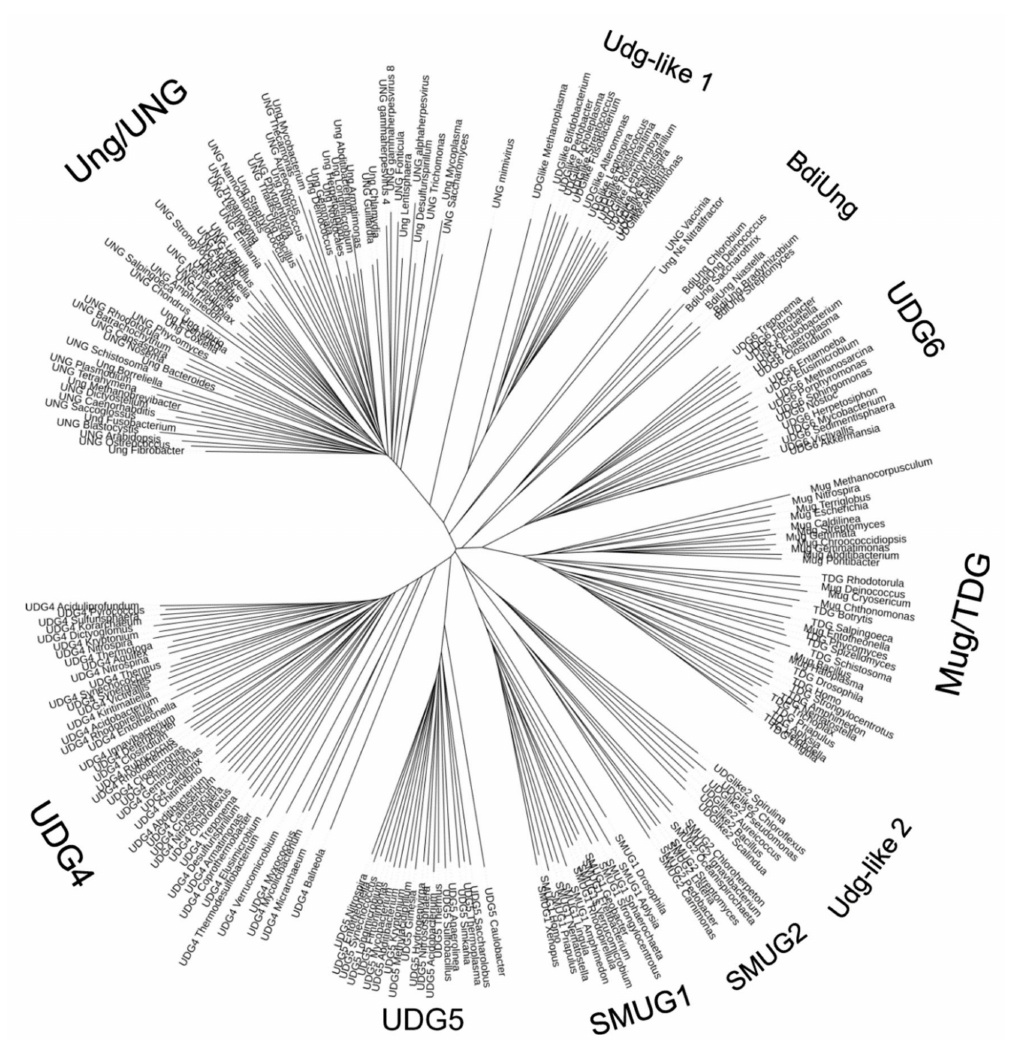
Figure 3. Unrooted tree of uracil–DNA glycosylases, limited to one per taxonomic phylum. The phylogenetic tree was produced by Clustal Omega [124] and visualized using iTOL